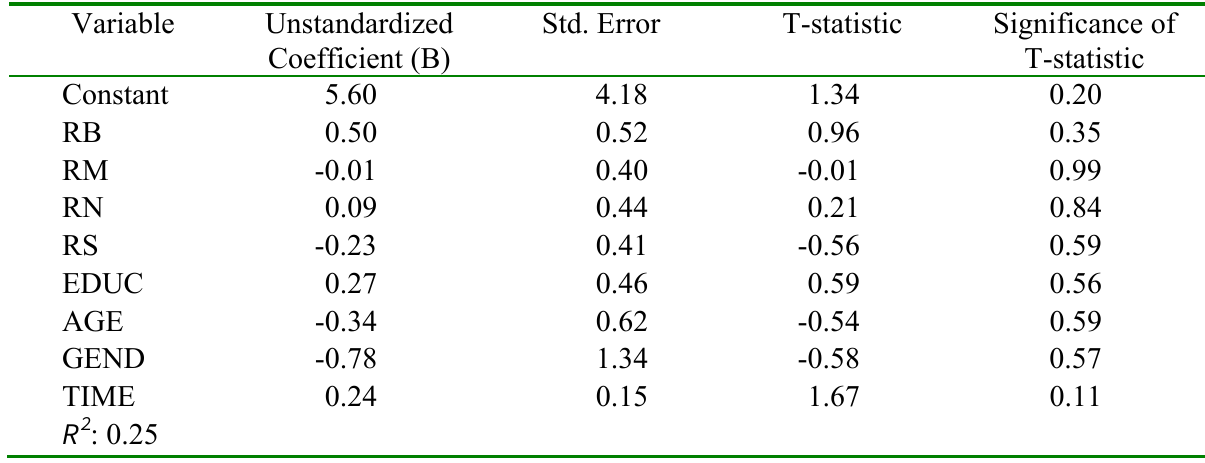
Regression Analysis of Reading